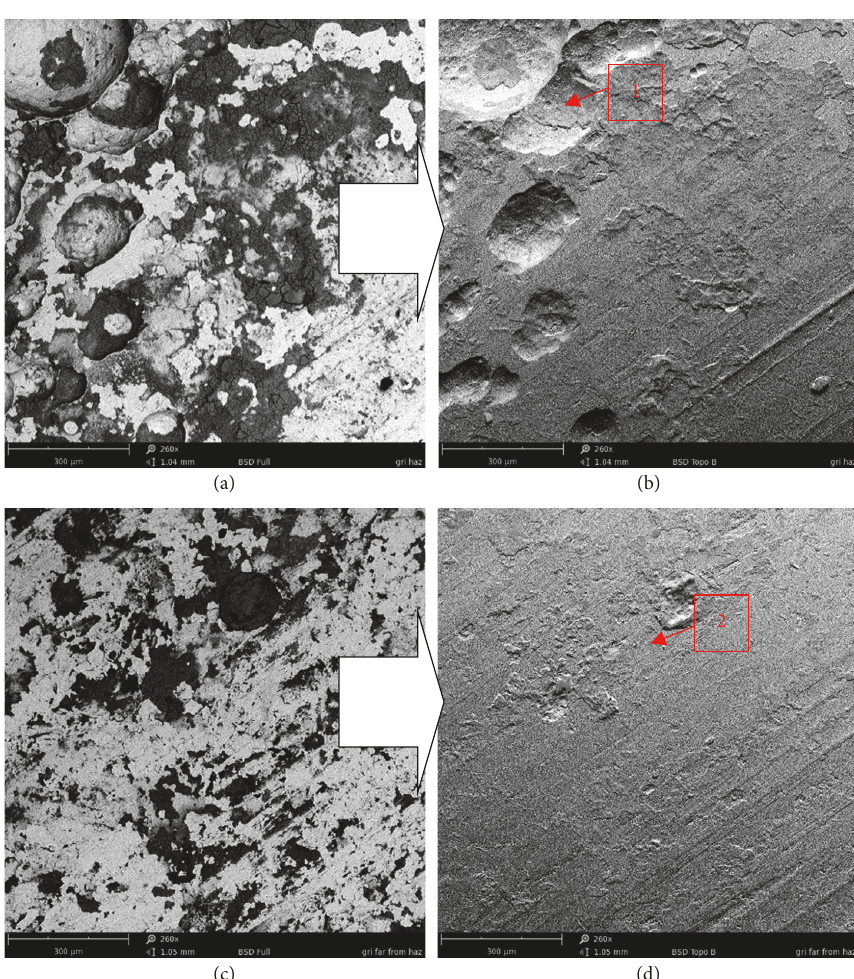
Figure 5: Comparison of grille surfaces observed in the heat affected zone HAZ (a, b) and in distance of HAZ (c, d). SEM-BSD and SEM- BSD-topo modes. Points 1 and 2 are locations of chemical analysis; results presented in Figure 6 and Table 2.